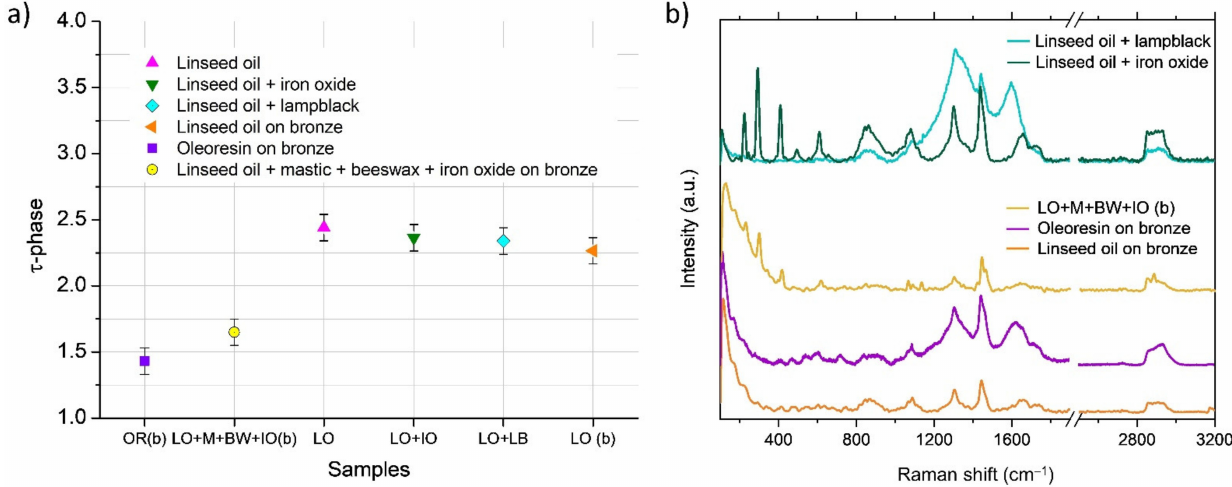
Figure 5. FL ( a ) and Raman ( b ) results for pigmented and non-pigmented mixtures laid on glass and metal substrates. Raman spectra are plotted after baseline subtraction (default function in TWiRE